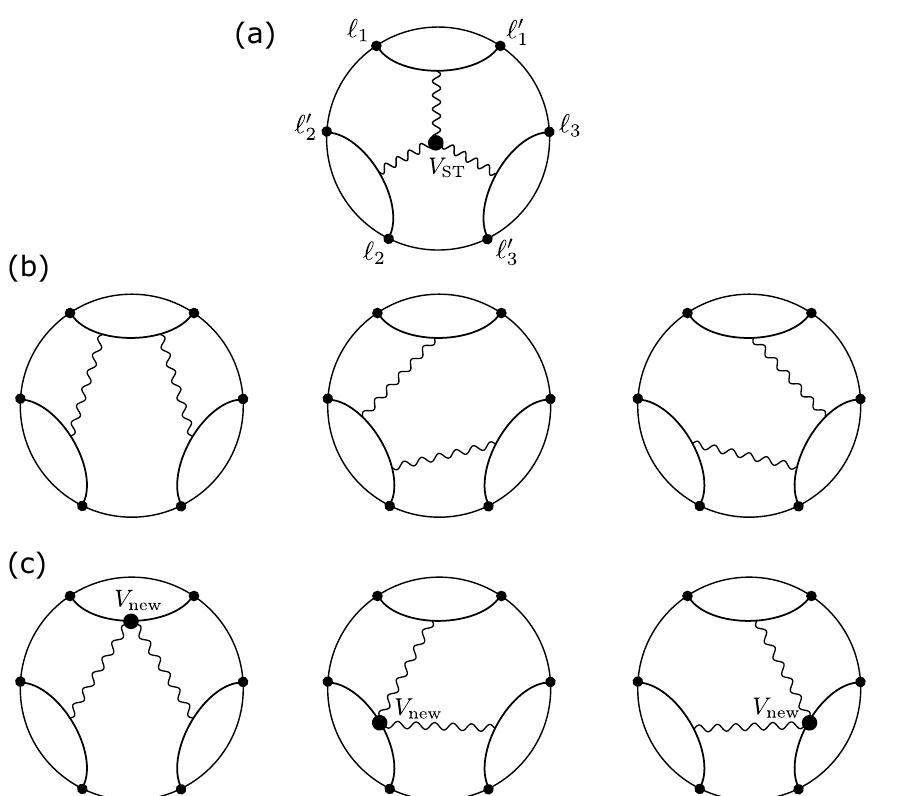
) O ( ‘ ) O ( ‘ ) i of three bound- 0 0 2 , ‘ 3 , ‘ 1 2 3